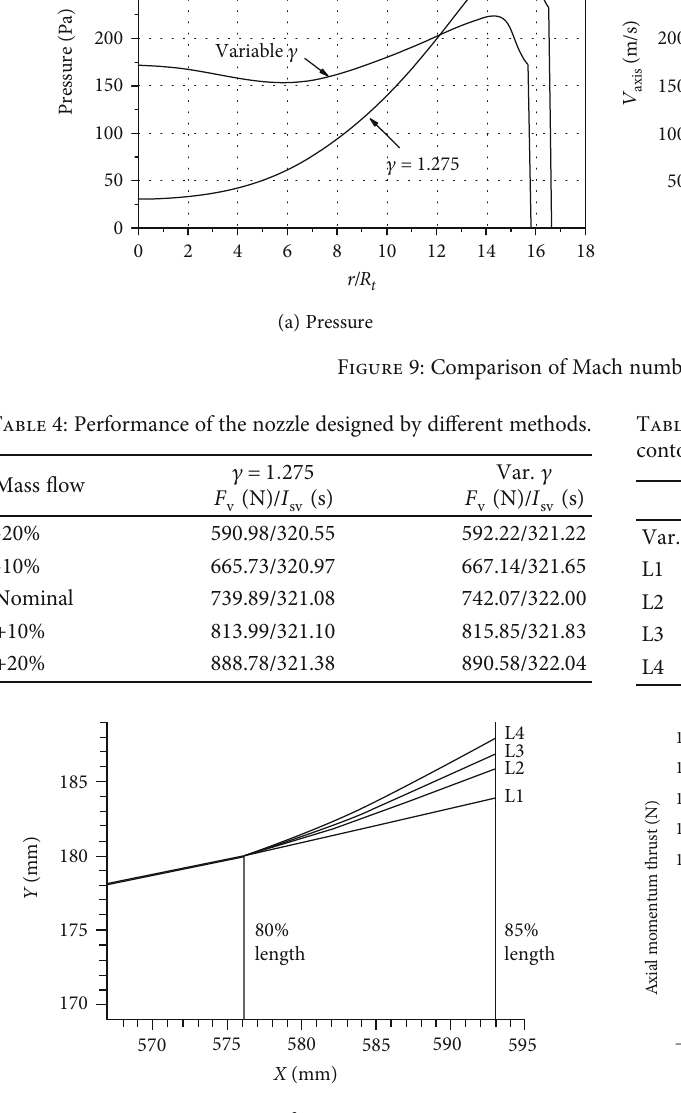
Figure 10: Comparison of various extension curves.